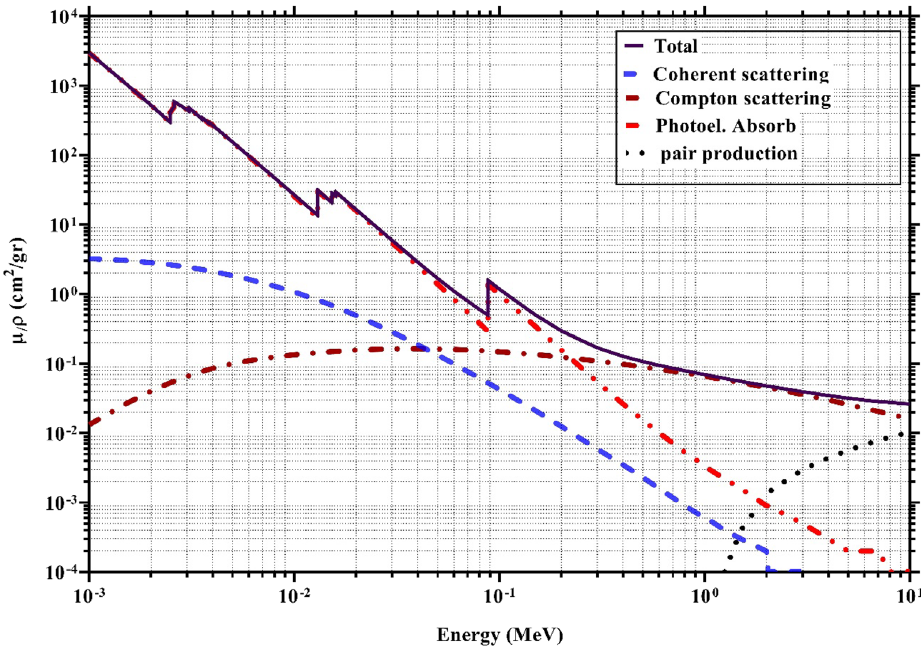
Figure 9. The partial and total mass attenuation coefficients for the selected sample